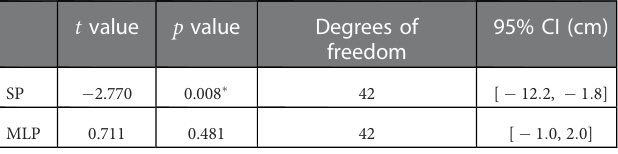
Statistically signi fi cant differences are indicated with the superscript ( (cid:6) ).